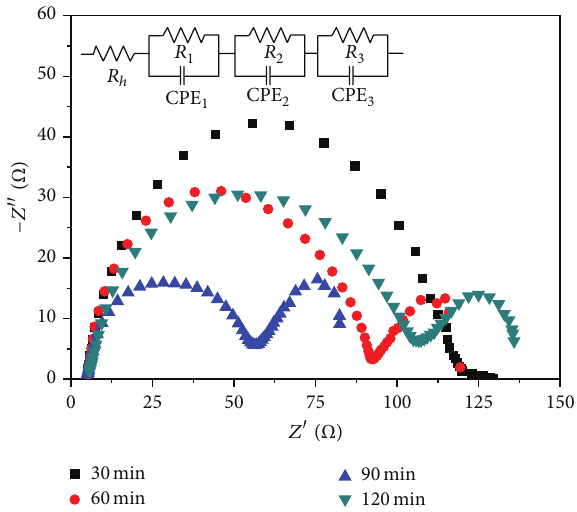
Figure 6: EIS spectra of DSSCs with the ZnO nanowires grown at different time, and shown in the inset is the equivalent circuit